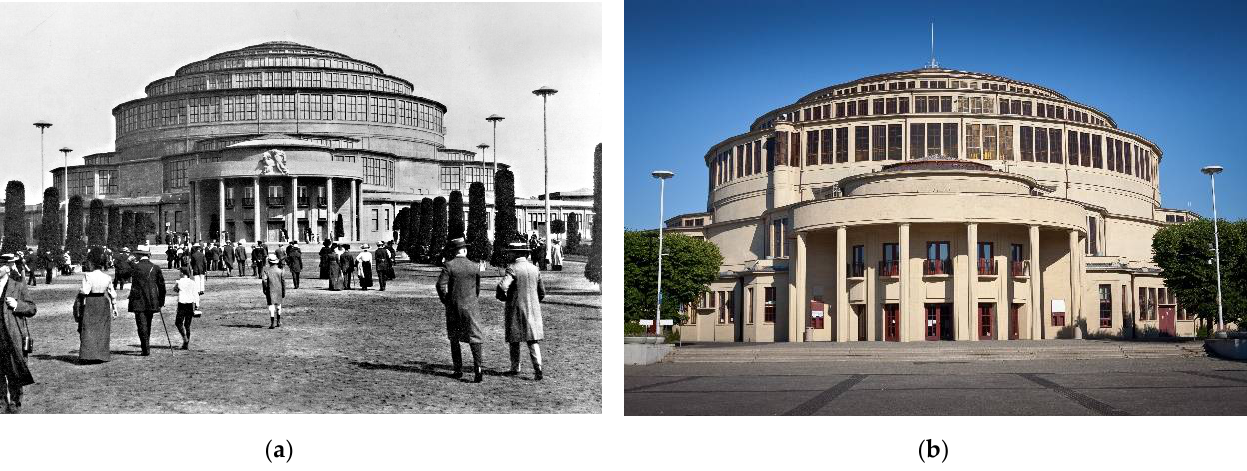
Figure 1. Centennial Hall built in 1910–1913, designed by Max Berg: ( a ) during the Centennial Exhibition in 1913, Dekorative Kunst , 1912–1913, p. 537; ( b ) after renovation in 2009, contemporary view (photo M. Kulczyński).